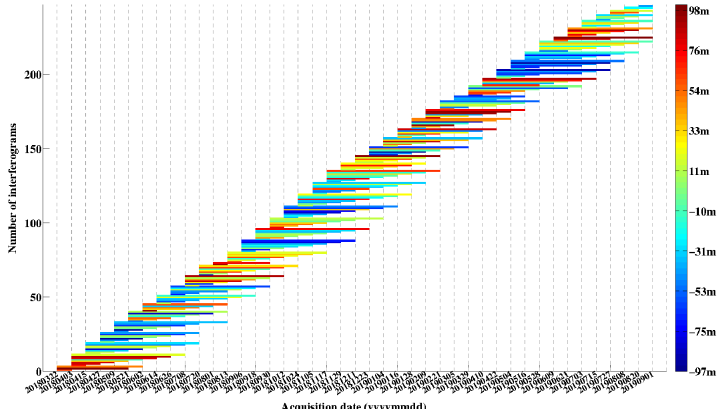
Figure A5. The distribution of the temporal and spatial baselines from Sentinel-1A with descending orbit between 22 March 2018 and 1 September 2019.